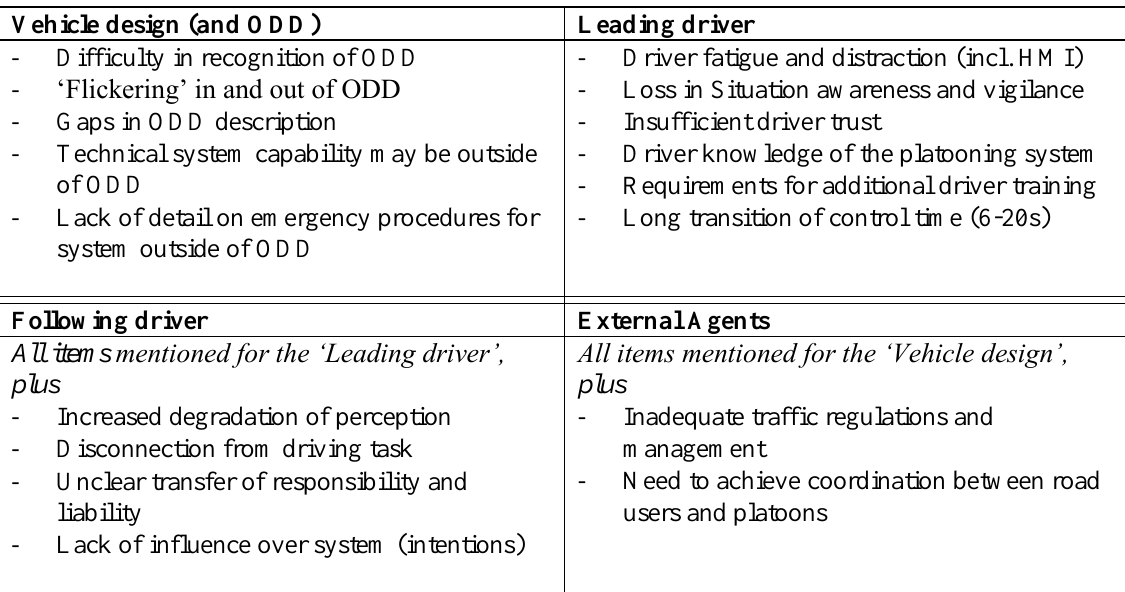
Issues and challenges for cooperative truck control per considered agent Vehicle design (and ODD) Leading